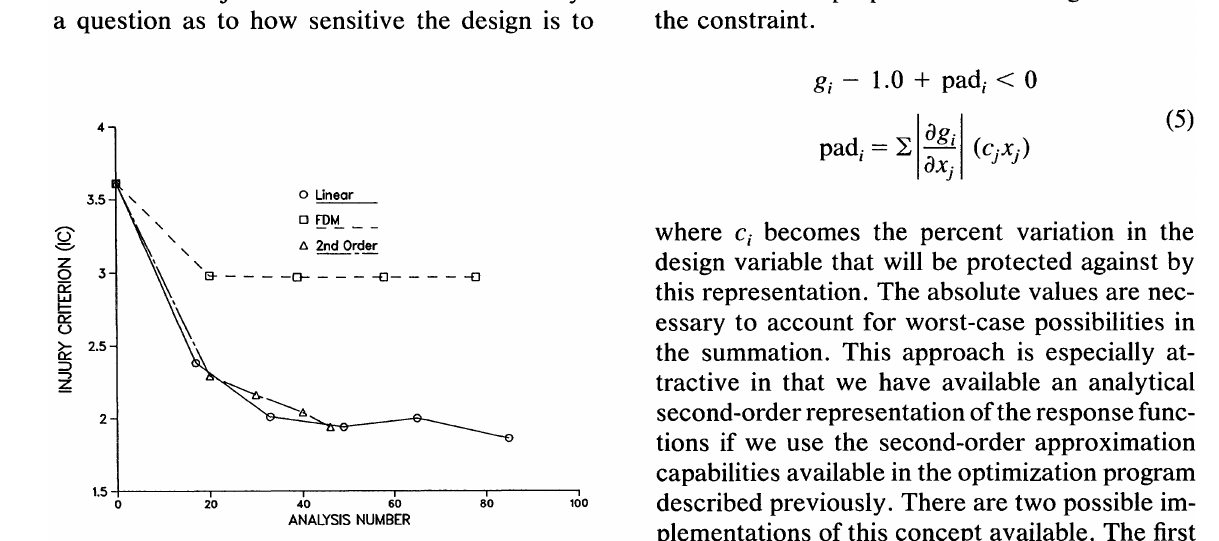
FIGURE 7 Optimization histories for example